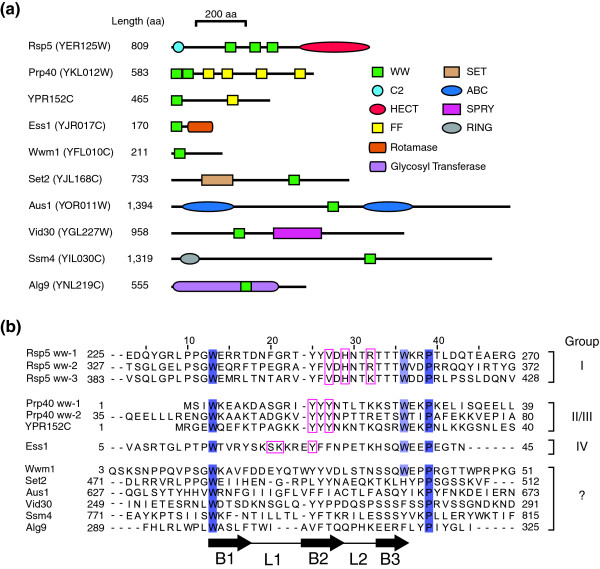
Motifs in yeast WW domain proteins and WW sequence alignment. (a) Ten yeast proteins contain a total of thirteen WW domains. (b) Multiple sequence alignment of the 13 WW domains. The domains from Rsp5 and Prp40 are named corresponding to their occurrence from amino to carboxyl terminus. Conservation of the tryptophan residue at position 13 and the proline residue at position 39, as well as partial conservation of the tryptophan at position 36 define the WW domain (filled blue boxes). The sequences shown were purified as fusions to either MBP or GST. Residues boxed in red residues indicate the sequence determinants that put the WW domains into three different classes: groups I, II/III and IV [13]. Six of the WW domains do not conform to any of the classifications.